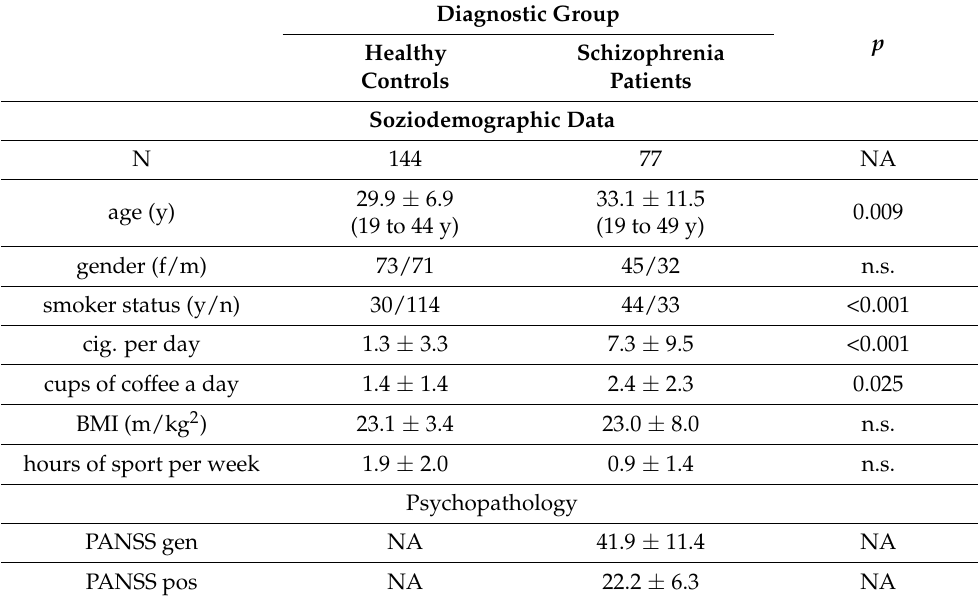
Table 2. Demographic Characteristics of Healthy Controls and Unmedicated Schizophrenia Patients.